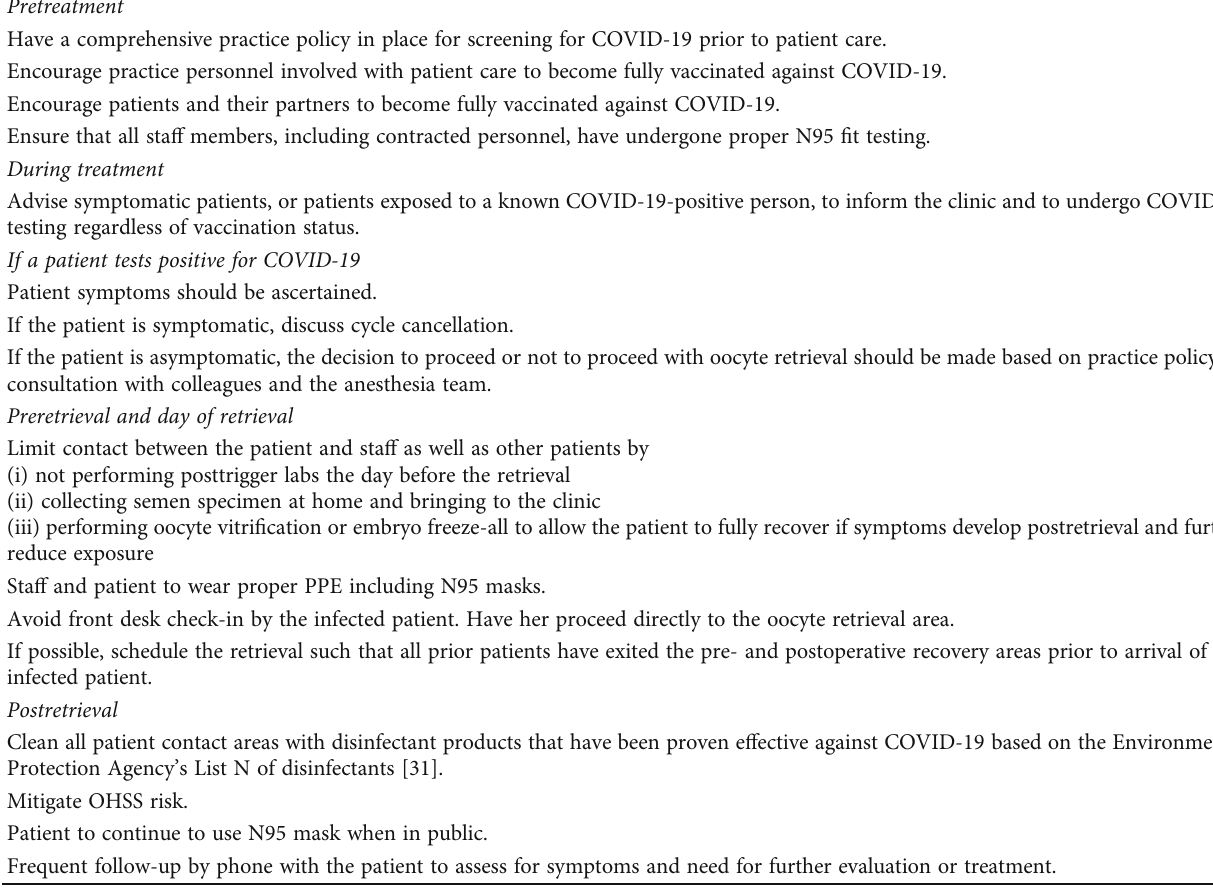
Table 1: Considerations for patients with asymptomatic COVID-19 infection undergoing ovarian stimulation.